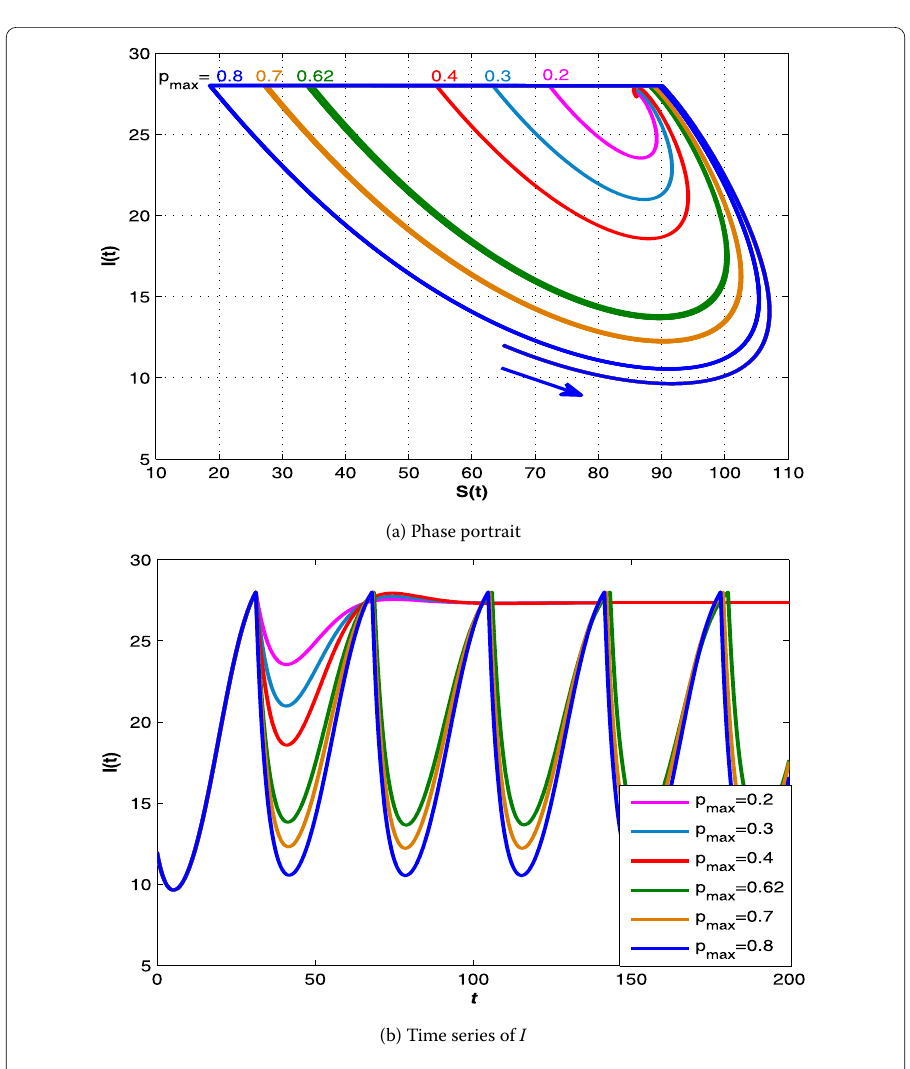
Figure 4 The trajectories of model (4.1) with RL = 28 > I ∗ and p max = 0.2,0.3,0.4,0.62,0.7,0.8. The initial value is ( S 0 , I 0 ) = (65,12).